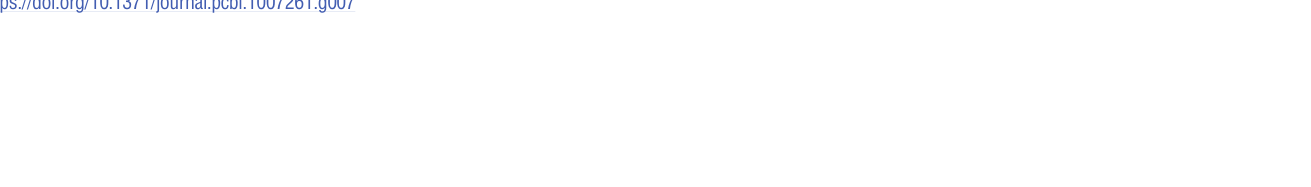
PLOS Computational Biology | https://doi.org/10.1371/journal.pcbi.1007261 August 18,